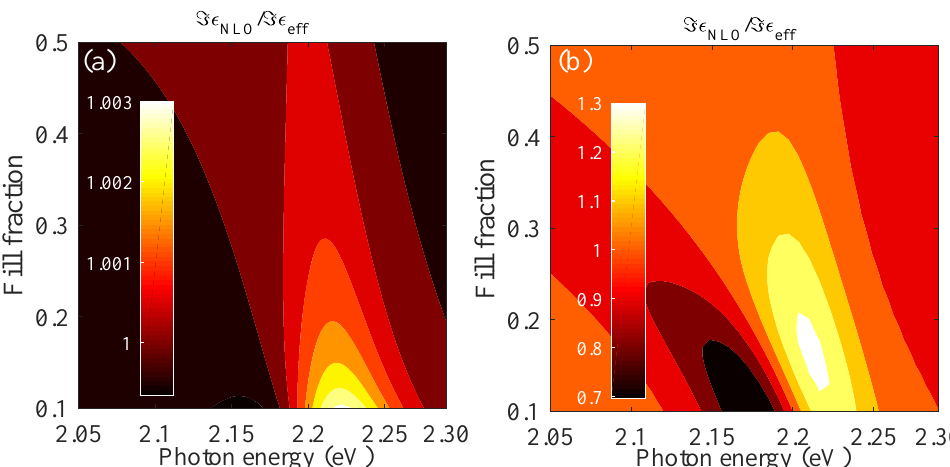
Figure 5. Imaginary part of the modified nonlinear permittivity, Equation (11), relative to the linear case for gold using the data fitted to available experimental data [20]. Results for ( a ) Bruggeman and ( b ) Maxwell–Garnett theory for varying fill fractions as a function of incident photon energy are compared. The incident field is | (cid:126) E | 2 = 7 × 10 14 V 2 /m 2 . Note the strong difference in predicted changes in the local